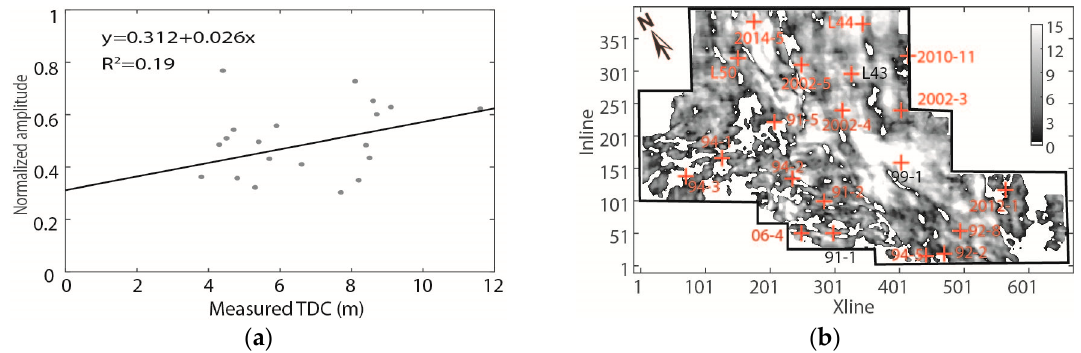
Figure 8. Cross plot between measured TDC and normalized amplitude ( a ), and amplitude predicted TDC thickness in meters ( b ).